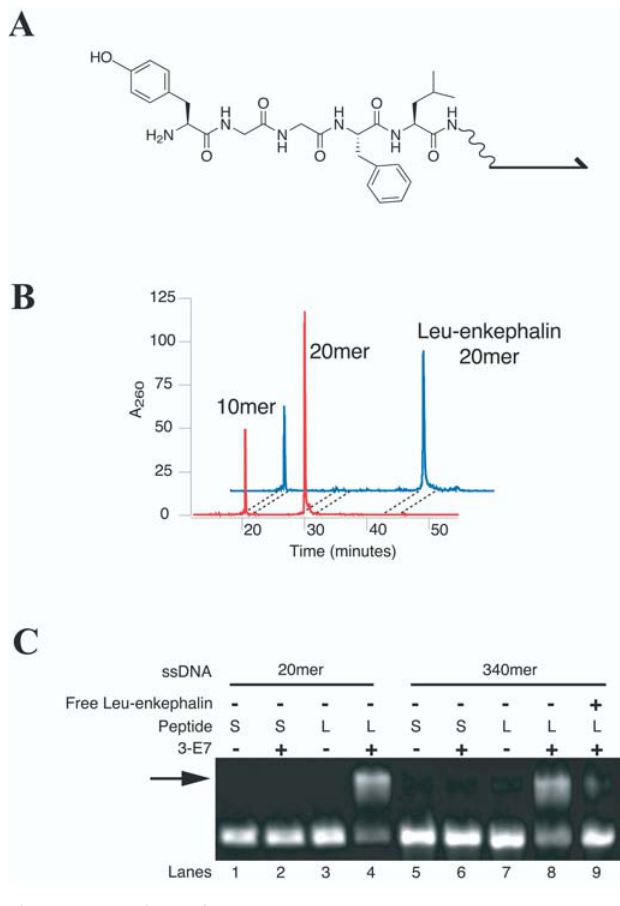
Figure 5. Peptide Synthesis on DNA (A) Structure of the [Leu]enkephalin–DNA conjugate. (B) High performance liquid chromatography chromatogram of the [Leu]enkephalin peptide synthesized using succinimidyl ester chem- istry on a 20-base oligonucleotide modified with a 5 9 primary amine (20mer). A 10-base oligonucleotide without the 5 9 primary amine (10mer) was included in the reactions as a control for nonspecific DNA modification. The red and blue traces are the DNA before and after chemistry, respectively. The mass of the major product peak (42- min retention time) matches the expected mass of the [Leu]en- kephalin–DNA conjugate. (C) Electromobility shift assay of peptides synthesized on 340-base ssDNA. Conjugates were eletrophoresed on a native agarose gel in the absence (lanes 1, 3, 5, and 7) or presence (lanes 2, 4, 6, 8, and 9) of the [Leu]enkephalin-binding antibody 3-E7. [Leu]enkephalin (L) or a scrambled sequence (S) was synthesized on a 5 9 amino-modified 20- base oligonucleotide, which was subsequently used as a primer for PCR (lanes 1–4), or directly on 5 9 amino-modified 340-base ssDNA, which was subsequently converted to dsDNA (lanes 5–9). Addition of free [Leu]enkephalin peptide (lane 9) competes away binding. DOI: 10.1371/journal.pbio.0020174.g005